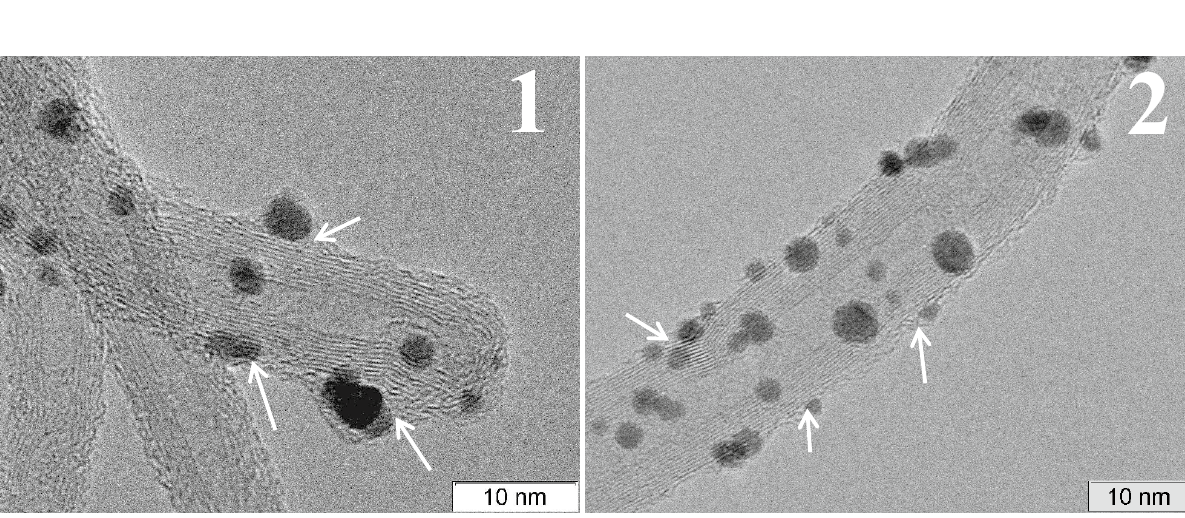
Table 2 Average size ( d average surface size ( d s ) of Pt nanoparticles obtained by microscopy (TEM) and gas- phase CO titration (GPT)